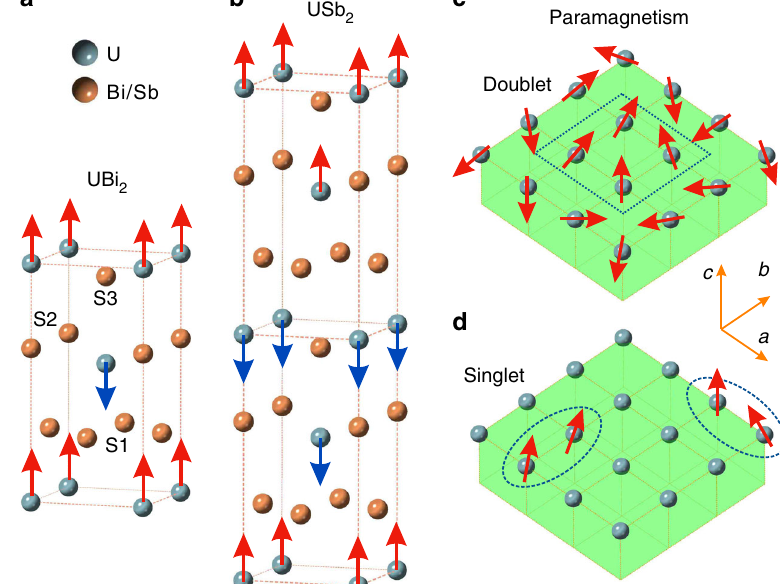
Fig. 1 Singlet ground state magnetism and the ligand cage of U(Bi/Sb) 2 . a , b The U(Sb/Bi) 2 crystal structure is shown with spins indicating the antiferromagnetic structure in UBi 2 ( T N ~180 K) and USb 2 ( T N ~203 K). The uranium atoms have 9-fold ligand coordination with base (S1), middle (S2), and pinnacle (S3) ligand layers as labeled in a with respect to the central uranium atom. c , d In-plane ferromagnetic nucleation regions are circled in c doublet and d singlet ground state magnetic systems. The singlet crystal fi eld ground state has no local moment, causing much of the lattice to have little or no magnetic